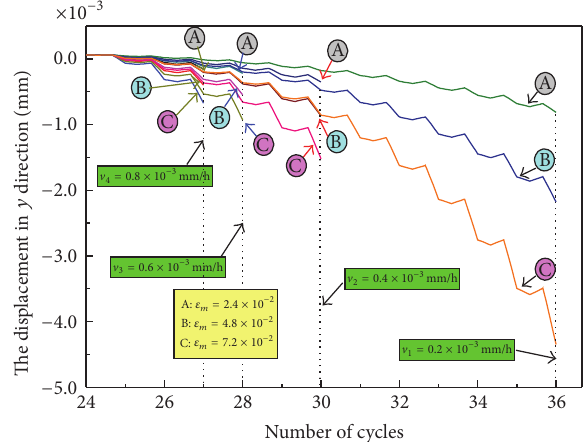
Figure 9: The plot of displacement in 𝑦 direction for node number 517 at the base of the surface groove against the number of thermal cycles with all conditions of MZ growth